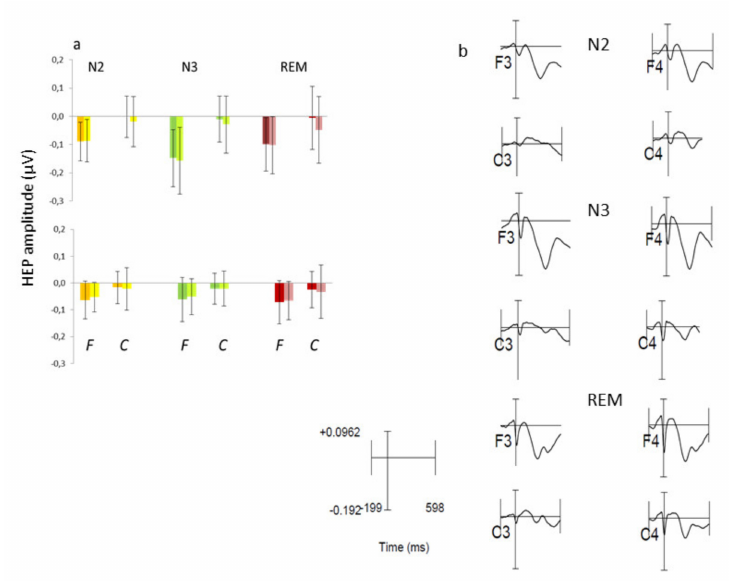
Figure 2. HEP amplitudes (mean, SD) during N2, N3, and REM sleep at frontal (F3, F4) and central (C3, C4) sites. ( a ) Dark and light colors indicate left and right sites, respectively, in N2 (yellow), N3 (green), and REM (brown). Upper and lower panels: early and late HEP components, respectively. ( b ) Average HEP signals at frontal and central sites.